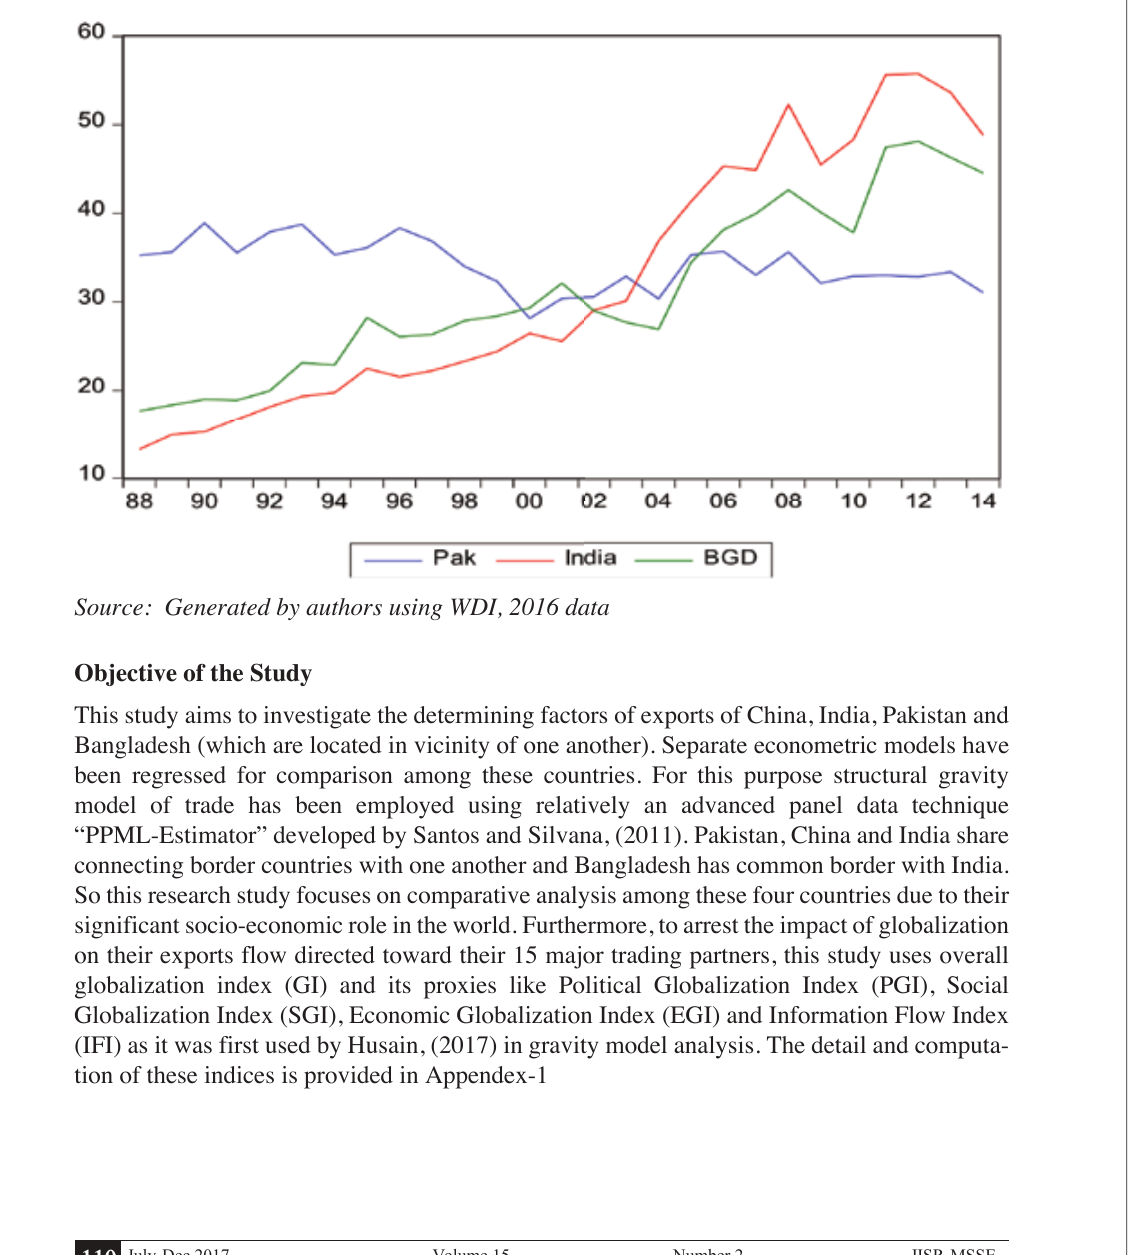
Figure-3 Exports percentage to GDP (1988-2016) for Pakistan, India and